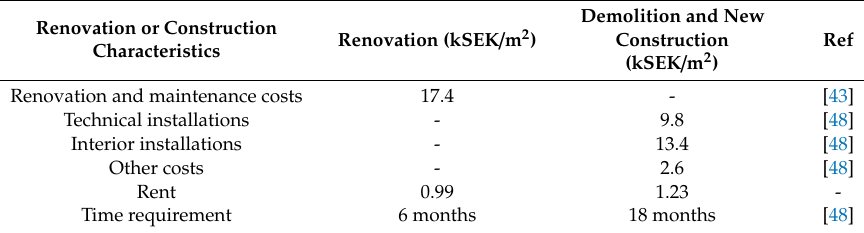
Table 13. Costs per apartment area for other renovations, excluding EEMs, additional costs for new construction, rent, and time requirement for performing renovation or demolition and